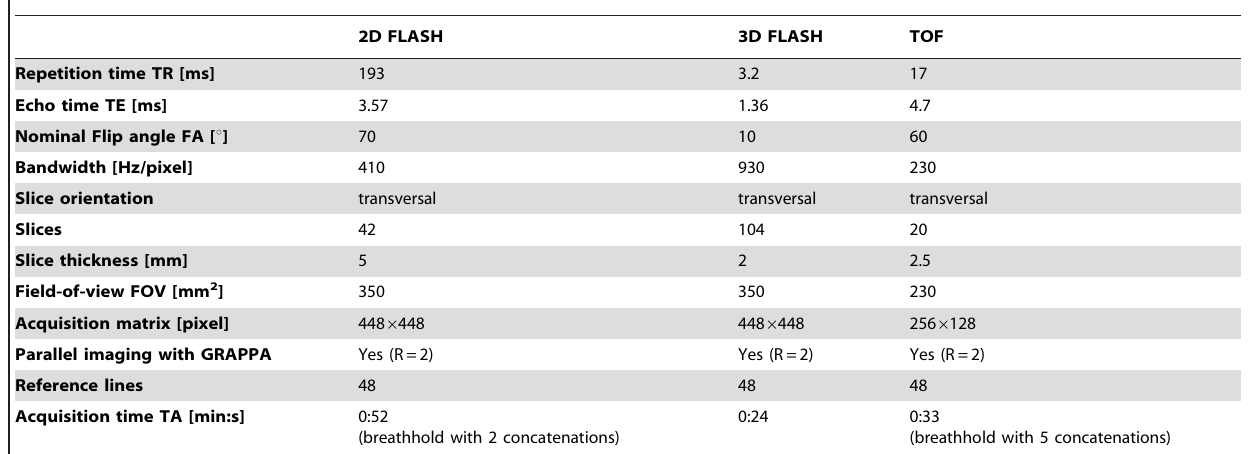
Table 1. Sequence